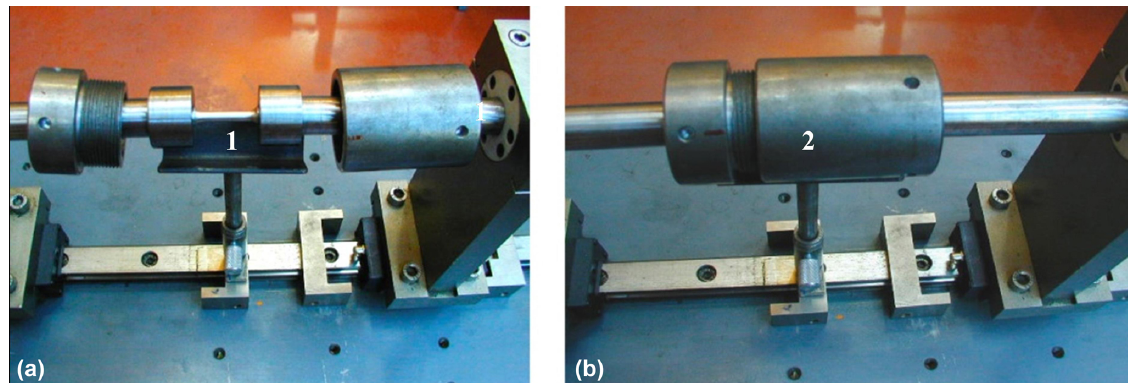
Figure 6. External interruption fixture when (a) unscrewed to insert the damping rings or access the specimen and (b) when screwed. Legend: (1) Specimen; (2) Interruption device.